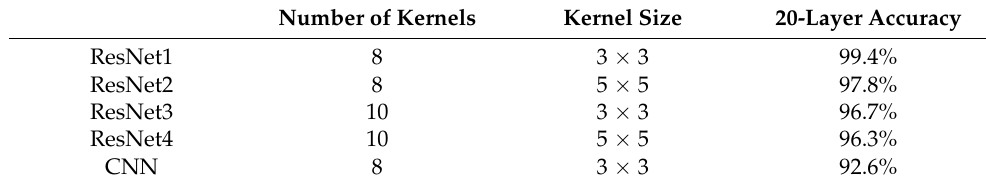
Table 2. Network parameter.